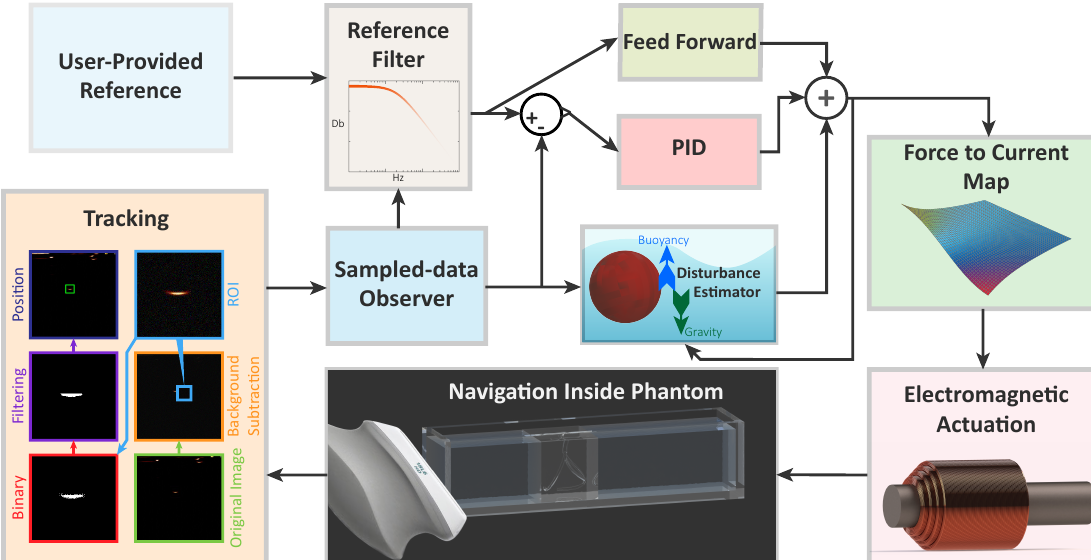
Figure 4. Schematic of the control loop. The user provides the position reference. This is preprocessed by a fourth order filter that removes frequency components above the bandwidth of the controller and ensures continuous derivatives. This prevents the filtered reference from increasing with a dynamic that is faster than the maximum one of the controller The filtered reference is then provided to a Proportional, Integral and Derivative (PID) controller. This controller designed to minimize disturbances with frequencies higher than a decade below that of the tracker [17]. A feedforward component is added to improve the control performance. As the low-level controllers feed the currents determined by the force-to-current map, the microrobot moves. This motion is detected by the ultrasound tracking algorithm using the procedure shown in the image (combined with the approach of Figure 3). Such tracking procedure begins using a Gaussian mixture-based segmentation algorithm for background subtraction [18]. A Region Of Interest (ROI) around the estimated position of the microrobot is then selected and binarized using a variable-threshold. A dilation morphological filter is then applied to the image. Finally, the center of the largest blob is selected as the position of the microrobot. The computed position is then provided to a sampled-data observer, which provides the controller with intersample state estimations